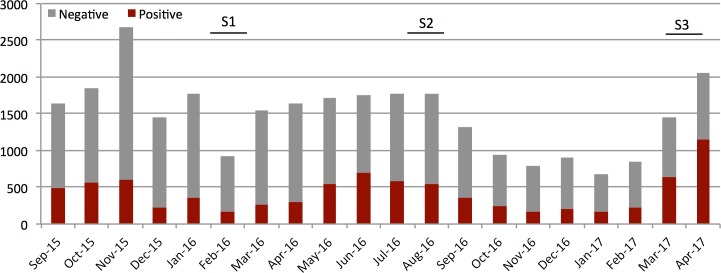
Number of positive (red portion) and negative (grey portion) RDTs performed by CHWs per month over the study period in 16 intervention CUs.The first full month of testing for the first 11 CUs was September 2015, and the first full month of testing for the remaining 5 CUs was October 2015. The study continued until the last CU had participated for 19 months (April 2017). Survey periods of 6, 12, and 18 months are indicated. Monthly fluctuations in testing rates are related to fever prevalence and possibly holiday travel (December–January). Seasonal rains in March–June usher in the high malaria season, which typically continues through July. Annual variations in rainfall and overall transmission are common. CHW, community health worker; CU, community unit; RDT, rapid diagnostic test.